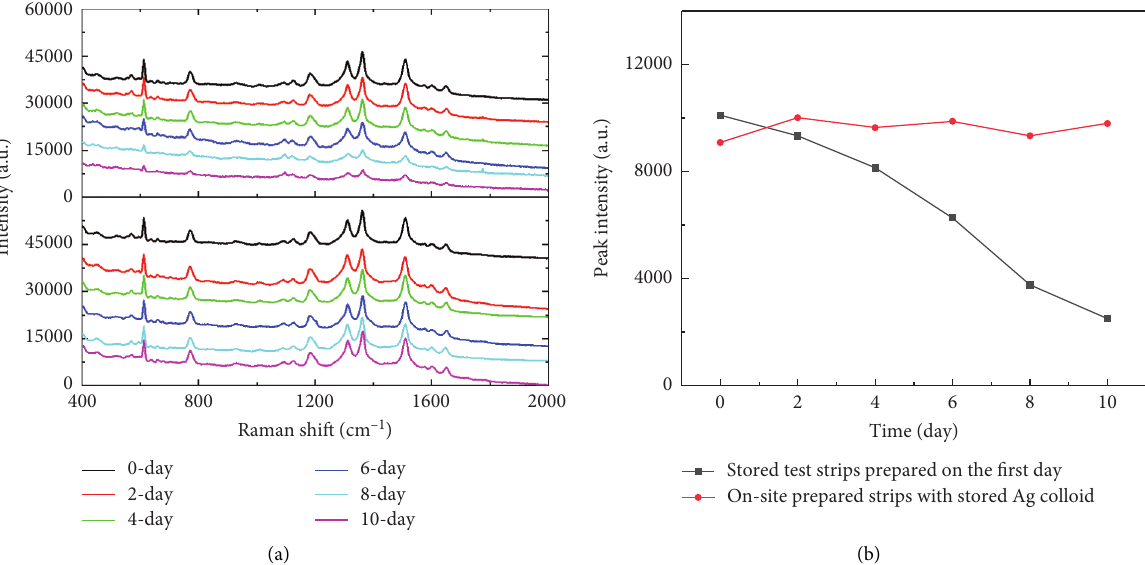
Figure 4: (a) The Raman spectra of 0.5mM of Rh6G sampled by sealed predeposited strips (up) and strips fabricated with the tactic (down) and (b) the 1364cm − 1 peak intensity plot of these spectra in ten